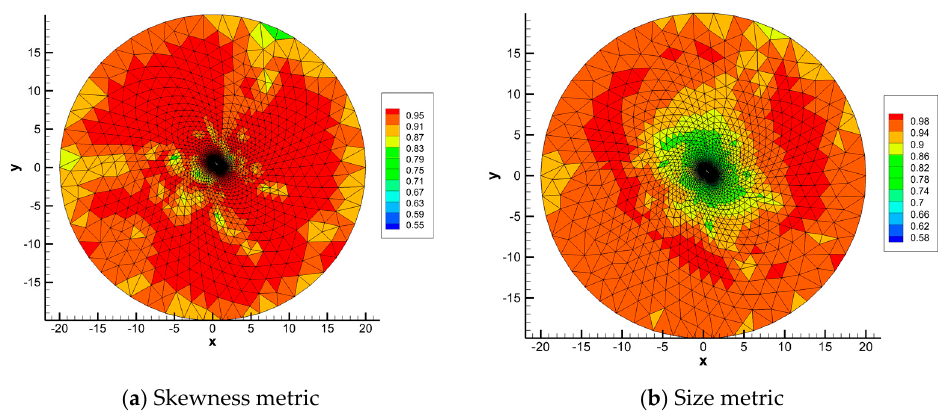
Figure 12. Mesh-based metrics of test case 2.